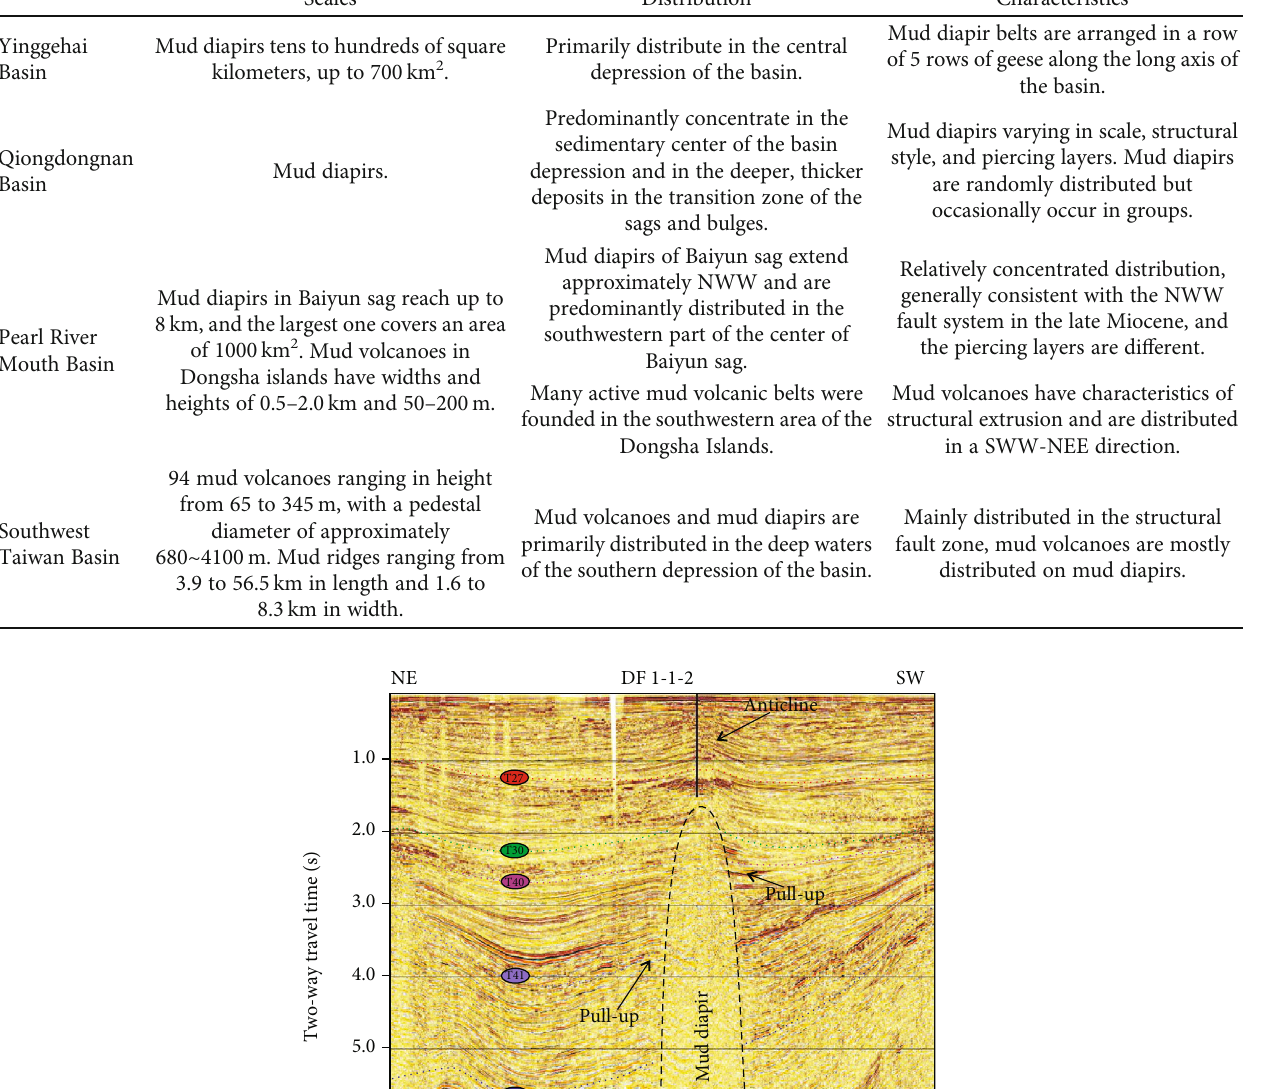
Table 1: Characteristics of mud volcanoes and mud diapirs in the northern South China Sea [25, 39, 43, 65 – 68]. Scales Distribution